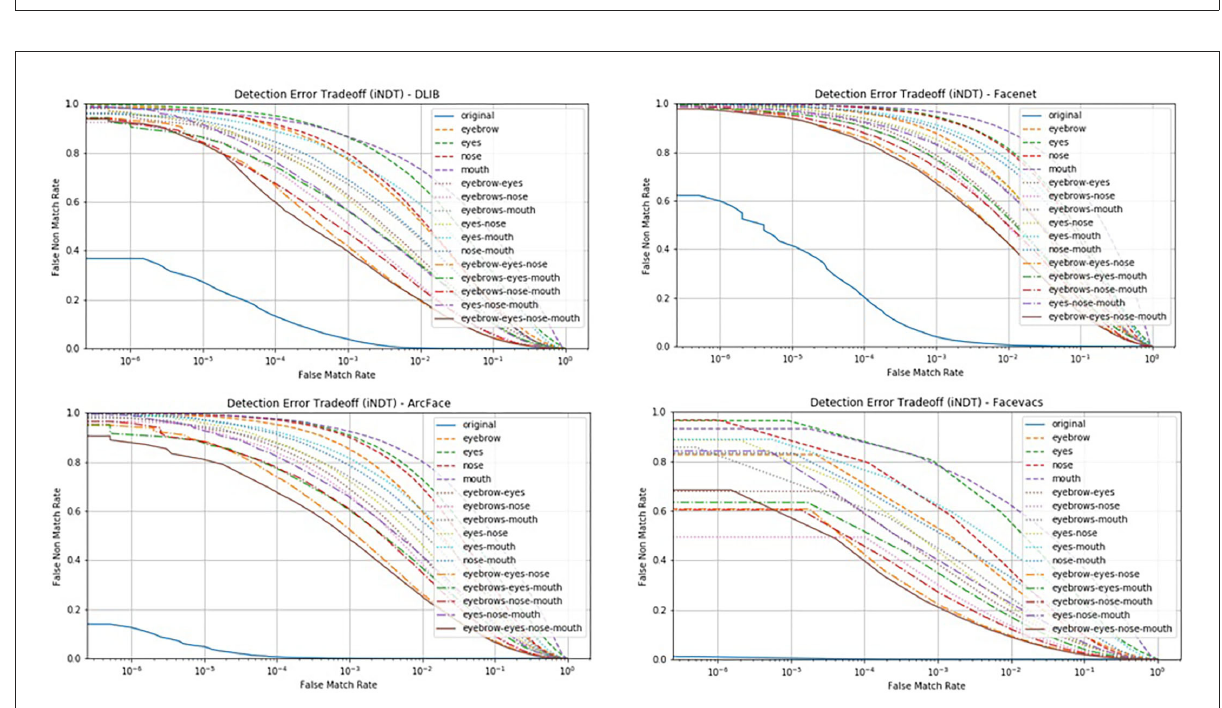
FIGURE7 Face part analysis of iNDT experiment using